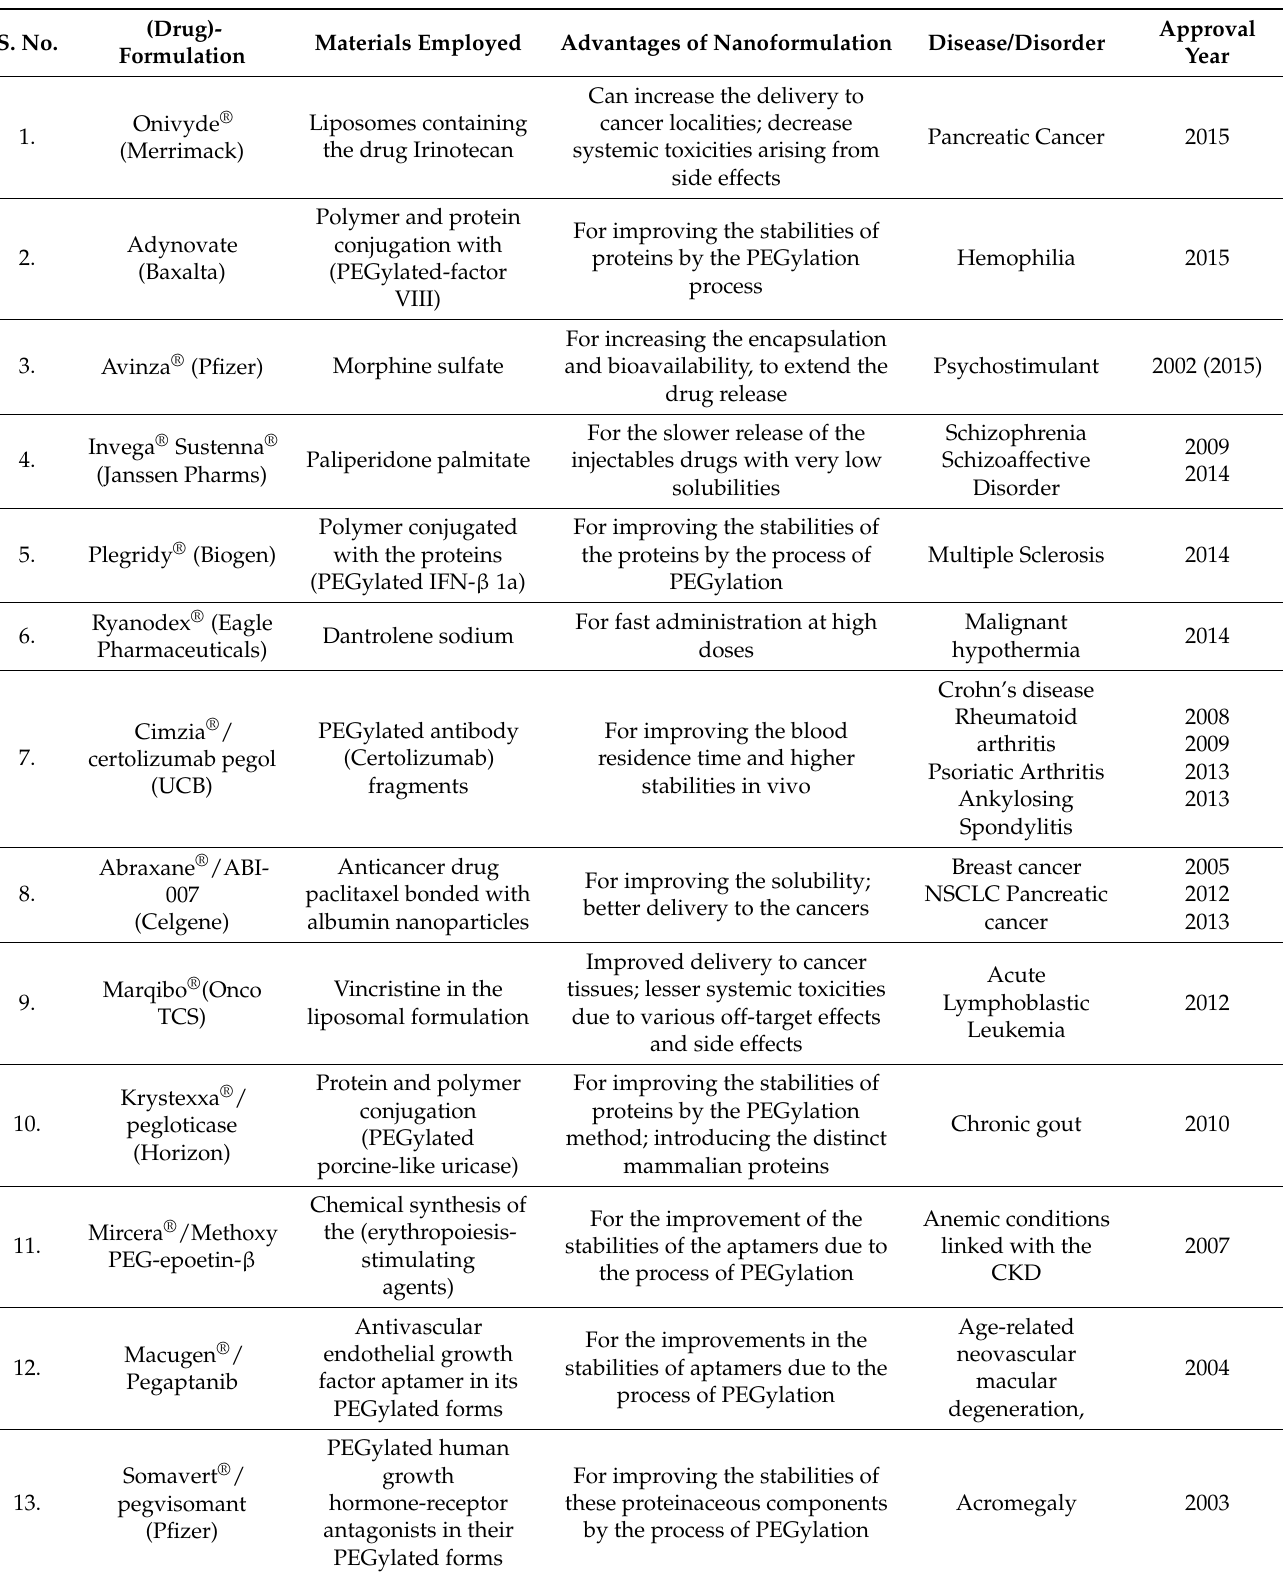
Table 5. Various nanoformulation-based medicines approved for the treatment of diseases and disorders (adapted from